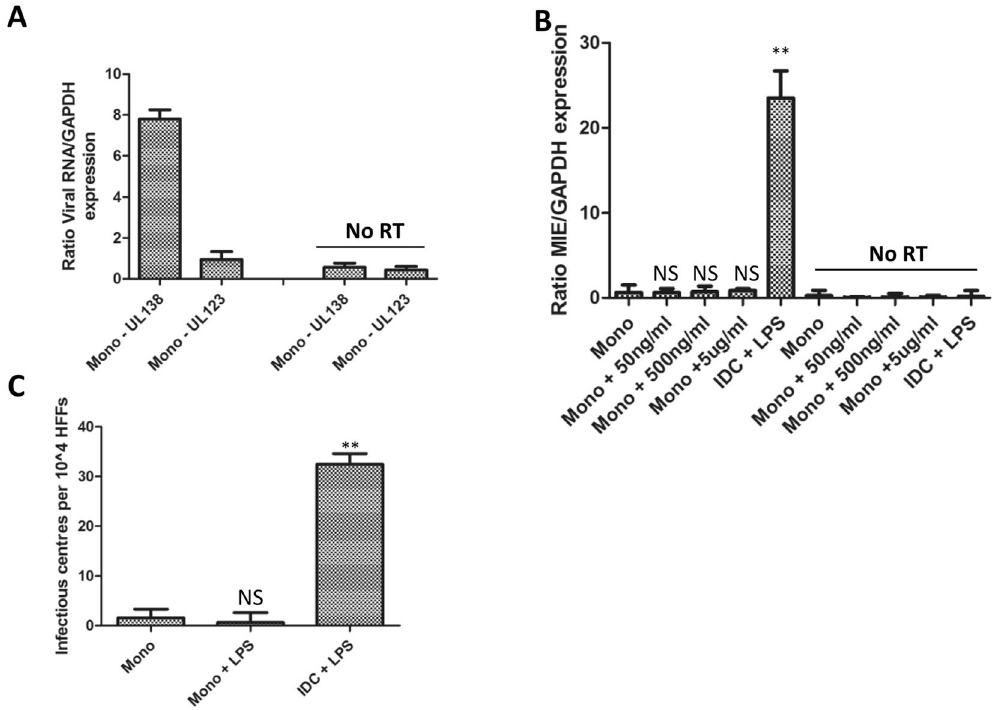
Figure 3. LPS does not induce IE gene expression in latently infected monocytes. (A ) Monocytes were infected with Merlin and 3 dpi analysed for UL138 and UL123 expression by qRT-PCR and then calculated relative to GAPDH control. RNA without prior RT was analysed concurrently (no RT) n = 3. ( B ) Latently infected monocytes were either treated with media alone (mono), 50–5000 ng/ml LPS (Mono + LPS) or differentiated with IL-4/GM-CSF and then stimulated with 50 ng/ml LPS (iDC + LPS). Eight hours post stimulation, RNA was harvested and analysed for UL123 (MIE) gene expression and expressed relative to GAPDH. RNA without prior RT was analysed concurrently (no RT) n = 3. ** p < 0.01; NS = non-significant difference when compared to monocyte control. ( C ) Latently infected monocytes were either treated with media alone (mono), 500 ng/ml LPS (Mono + LPS) or differentiated with IL-4/GM-CSF and then stimulated with 50 ng/ml LPS (iDC + LPS). Cells were then co-cultured with fibroblasts for 17 days which were stained for IE protein expression to identify infectious centres n = 3. ** p < 0.01; NS = non-significant difference when compared to monocyte